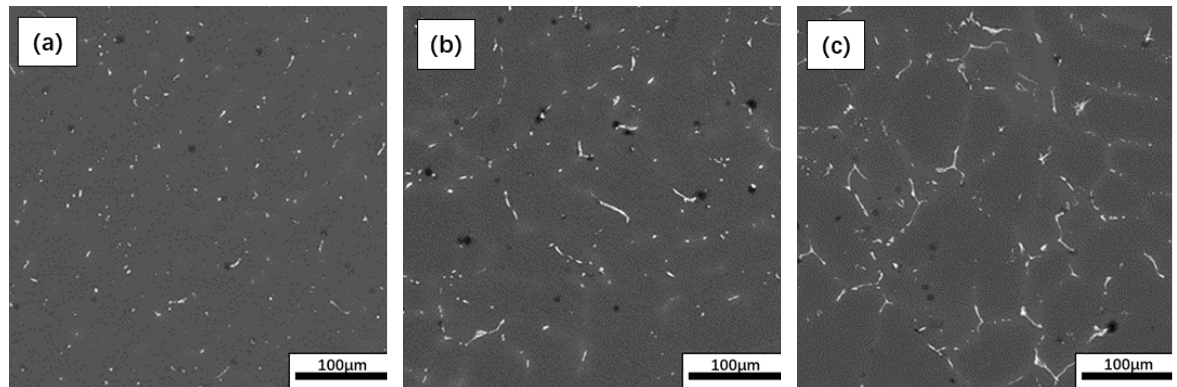
Figure 1. Backscatter plot of F-state Mg-Nd alloys: ( a ) Mg-1Nd, ( b ) Mg-2Nd, ( c ) Mg-3Nd.